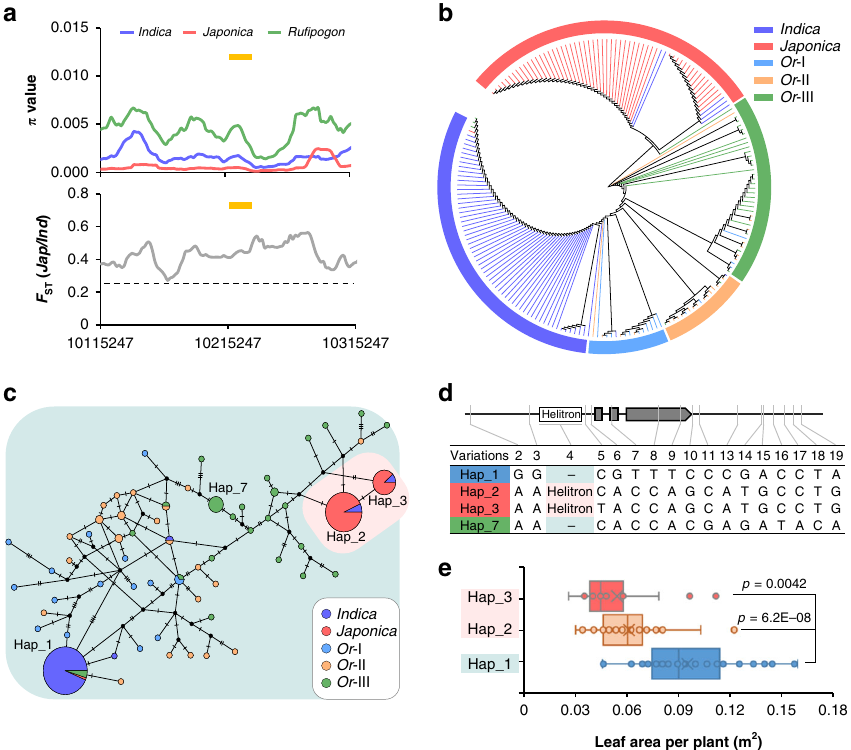
Fig. 5 Domestication of MYB61 in rice. a π and F ST values between indica and japonica in the 200 kb genomic region containing the MYB61 locus (the yellow line). The dashed line indicates the genome-wide threshold. b Phylogenetic tree of the MYB61 genomic sequences in the examined accessions. Or , O. ru fi pogon . c Phylogenetic network of MYB61 with pink and light green backgrounds denoting haplotypes containing the helitron insertion or not. The node size is proportional to the sample size. d Sequence alignment of MYB61 variations in the examined accessions. Blue background indicates haplotype in indica , red background indicates the haplotypes in japonica and green background indicates the haplotypes in common wide rice. The variations were placed on the schema of the MYB61 gene. e Boxplot of the leaf area of the rice accessions with haplotype_1 to _3. The mean value was obtained from nine individual plants of each accession. Box bounds represent the 25th and 75th percentile, center line represents the median, × indicates the mean, and whiskers represent the 25th percentile − 1.5 * the interquartile range and the 75th percentile + 1.5 * the interquartile range. Statistical signi fi cance was calculated with two-tailed Welch ’ s unpaired t -test and p values are indicated. The indication of pink and light green background in ( d , e ) is the same as in ( c ). Source data are provided as a Source Data fi